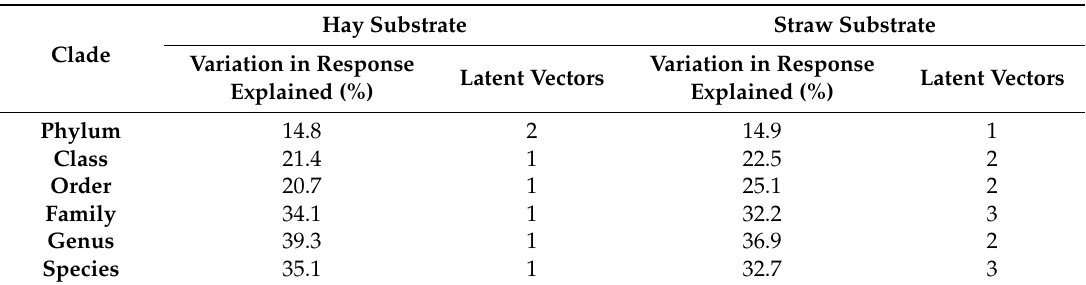
Table 3. Percentage of variation in fiber digestion explained by bacterial sequences classified at different clade levels. Hay Substrate Straw Substrate Clade Latent Explained (%)